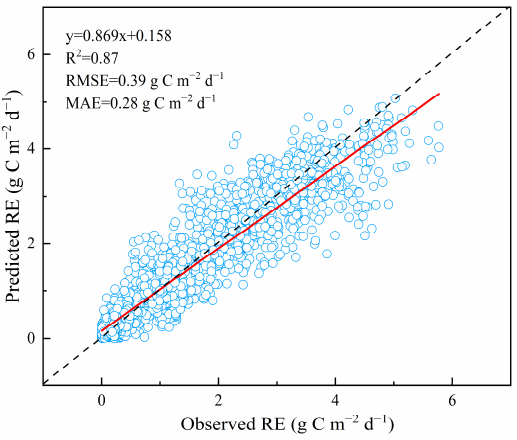
Figure 3. The predicted RE vs. the observed RE at the site scale.